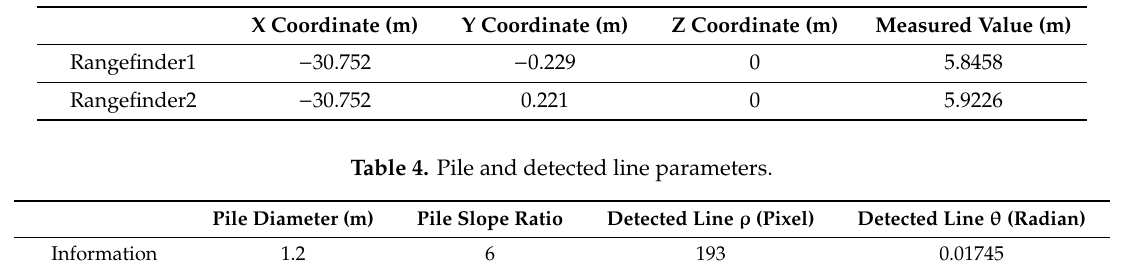
Table 3. Coordinates and the measured value of two rangefinders.